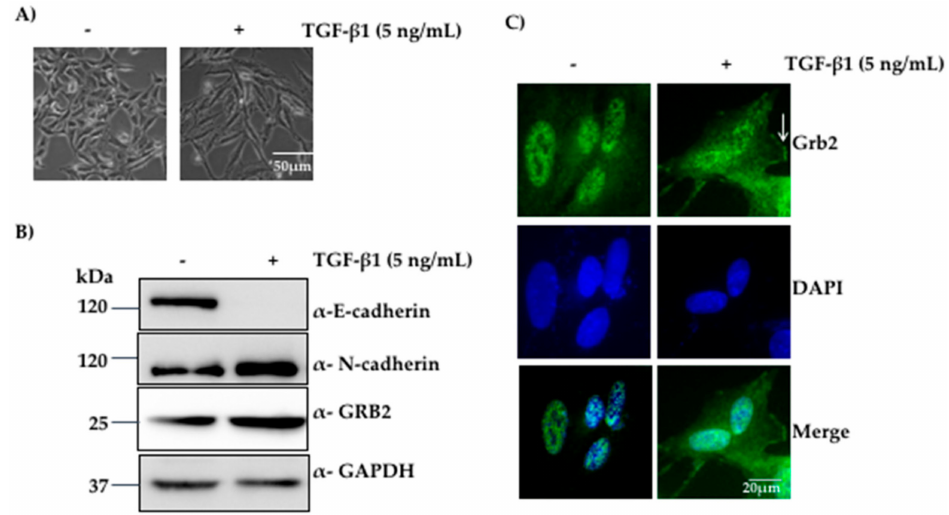
Figure 1. Expression of GRB2 was elevated during TGF- β 1-induced EMT in A549 cells. ( A ) A549 cells were visualised under 10 × objective after 48 h of incubation with or without 5 ng/mL of TGF- β 1 at 37 ◦ C; ( B ) Total cell lysate of untreated A549 cells and TGF- β 1-treated cells were probed by anti-GRB2, anti-E-cadherin (epithelial marker), anti-N-cadherin (mesenchymal marker) and anti-GAPDH (loading control) antibodies; ( C ) A549 cells, untreated or TGF- β -stimulated, were immunostained using anti-GRB2 (green) and DAPI